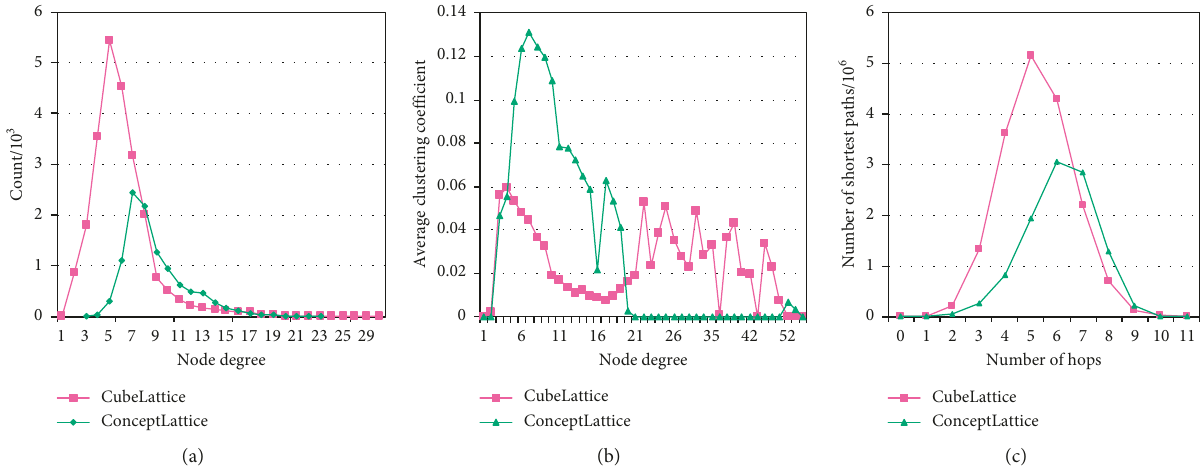
Figure 5: The structural characteristics between cube lattices and concept lattices. (a) Degree distribution. (b) Clustering coefficient. (c) Average path length.